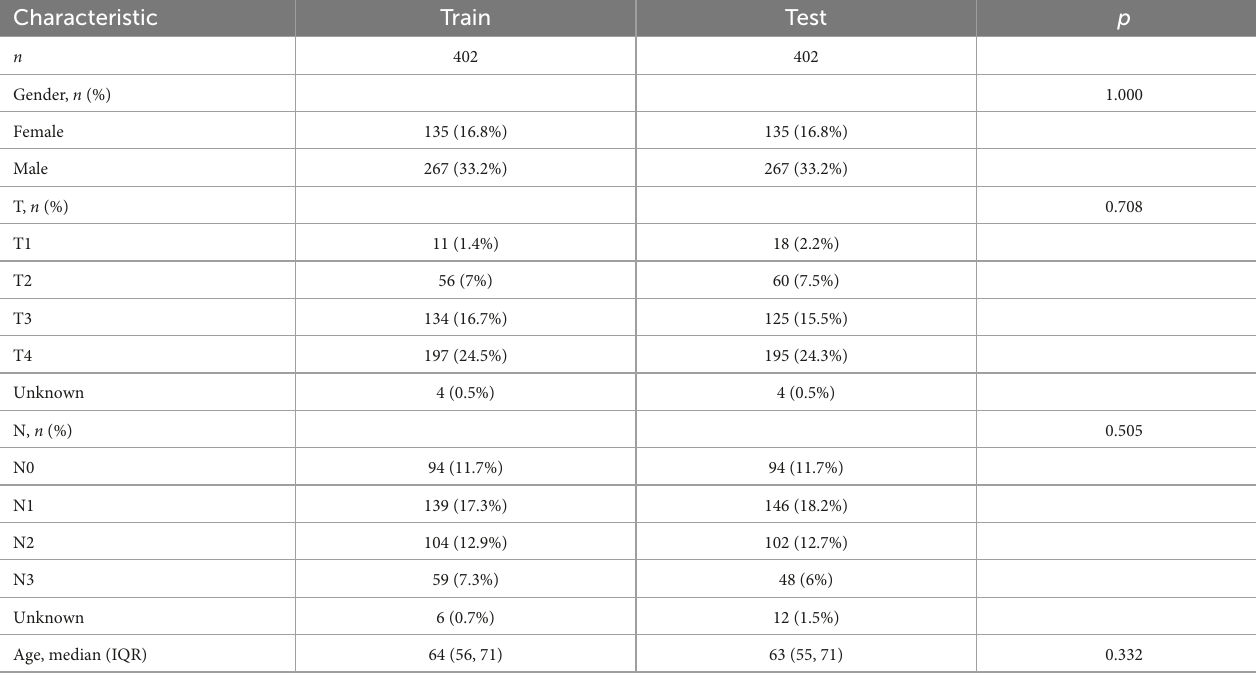
TABLE 2 The chi-square test of the relation between train set and test set. Characteristic Train